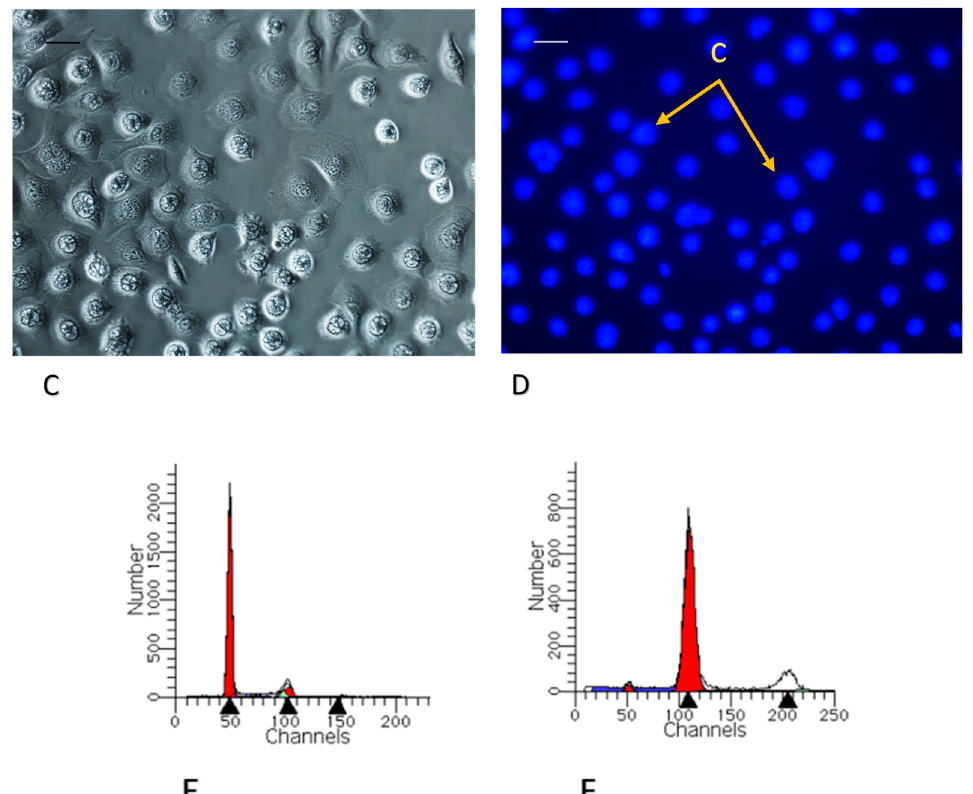
Figure 5. Results of nuclear staining with Hoechst 33285: SW480, untreated, 72 h incubation, phase contrast ( A ), UV excitation with blue/cyan filter ( B ): normal nucleus G1 (a), normal nucleus G2 (b); SW480, treated with 5b (10 µM), 72 h incubation, phase contrast ( C ), UV excitation with blue/cyan filter ( D ): giant nucleus (c). The bars in the upper left corner of each panel represent a length of 25 µm. The subfigures E and F show representative histograms of control ( E ) and 10 µM 5b exposed ( F ) SW480 cells. The 8n peak appears at an intensity of approx. 200.